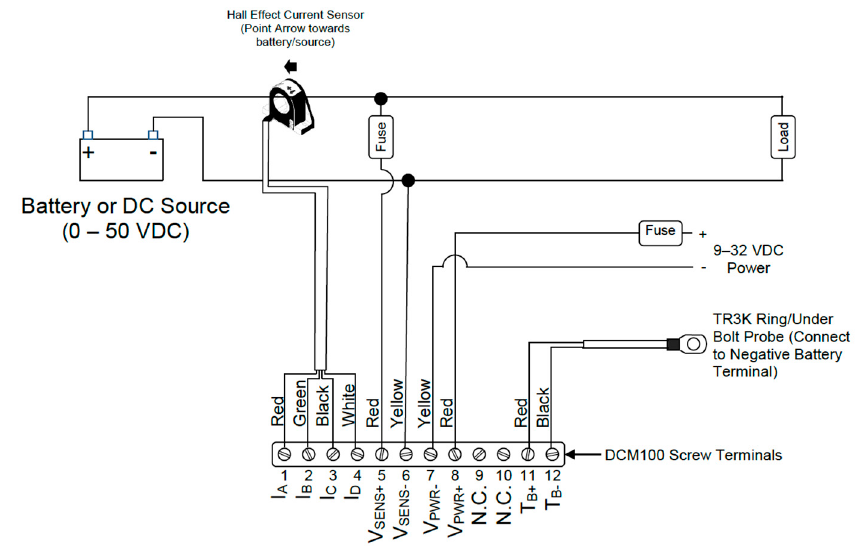
Figure 4. DCM100 connection diagram [71].